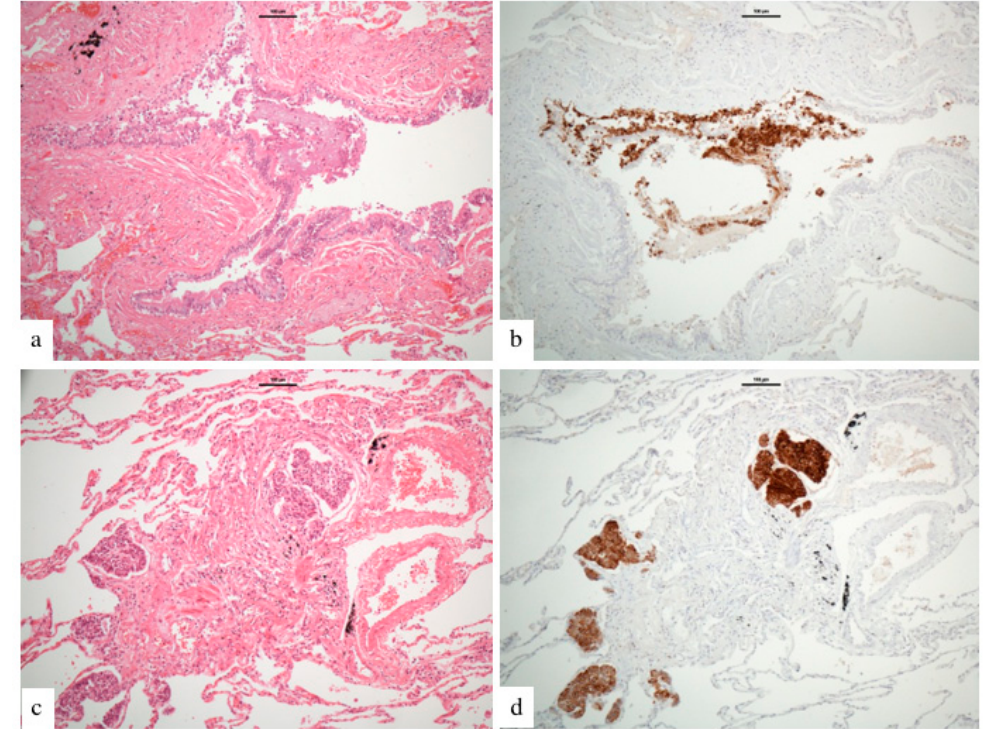
Figure 2. Histological features of DIPNECH in an adult female patient. ( a ) shows a bronchiole (hematoxylin and eosin stain) with ( b ) linear proliferation of neuroendocrine cells (brown immunostaining for chromogranin). ( c ) demonstrates a bronchiole (hematoxylin and eosin stain) with ( d ) multiple neuroendocrine tumourlets (brown immunostaining for chromogranin) ( × 100 magnification, scale bare 100 um).